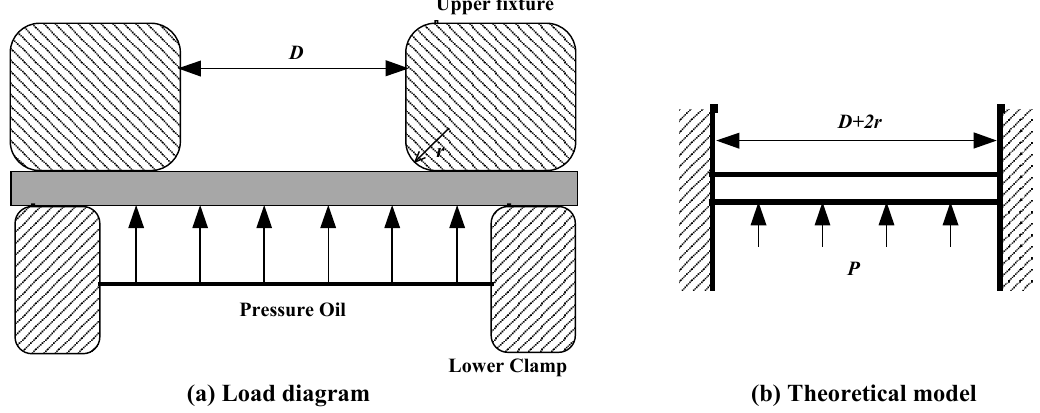
Figure 5. The mechanical model for yield strength. ( a ) Load diagram; ( b ) Theoretical model.